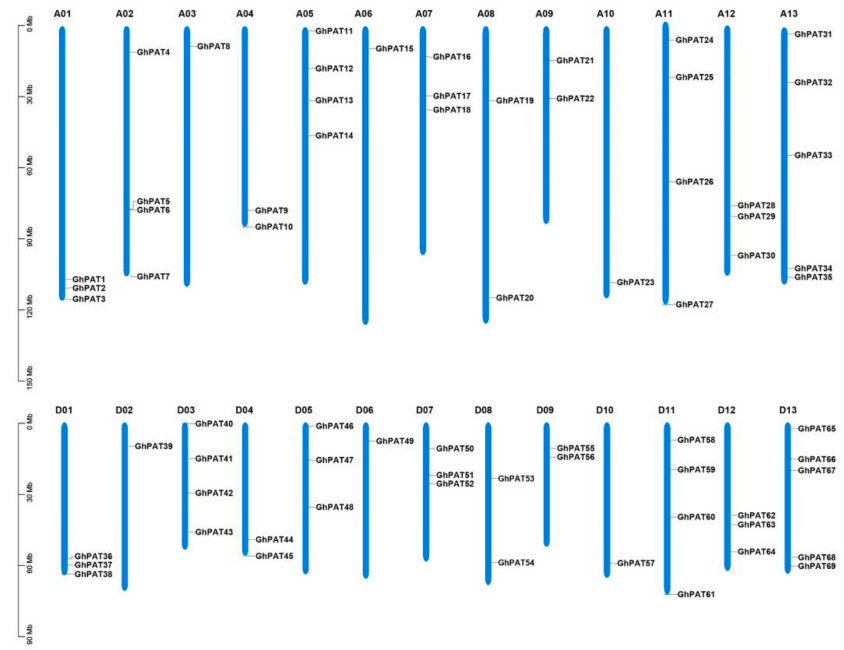
Figure 1. Location of the GhPAT family of genes on the